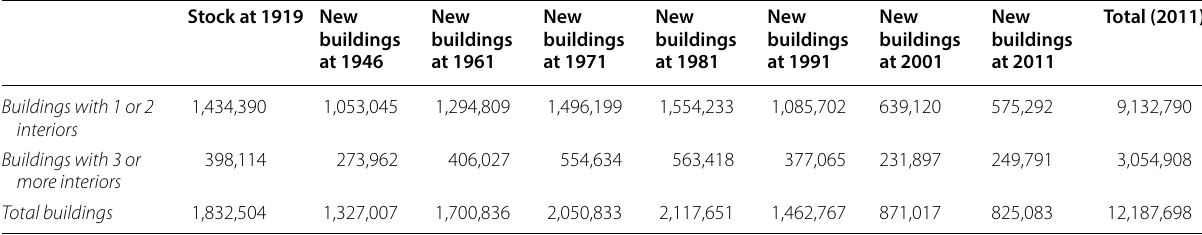
Table 1 Increase in residential stock 1919-2011, buildings listed by number of interiors. We highlight the intensity of the building cycle in the period 1960-1990 and the downsizing in the period 2001-2011 (authors’ calculations on data from Istat